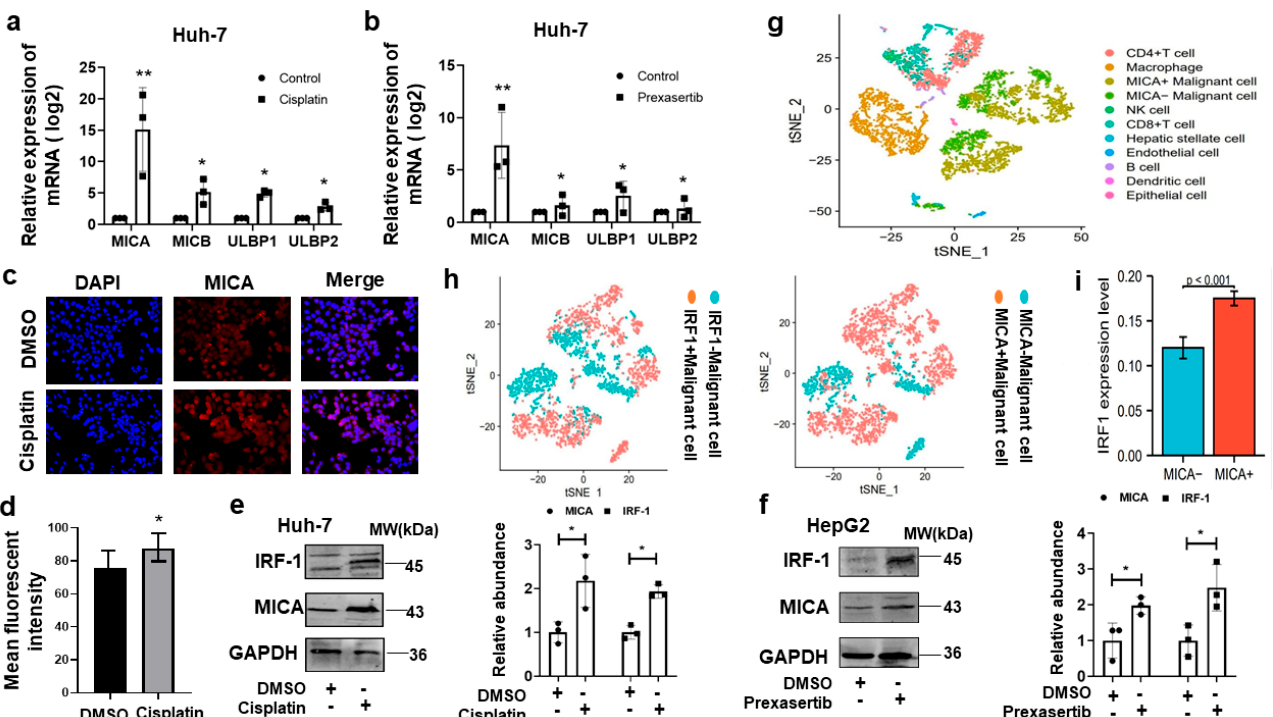
Figure 4. DNA damage induced MICA expression via IRF1 in HCC cells. The relative mRNA expression of NKG2D ligands is determined by qPCR in Huh-7 cells induced by cisplatin with a dose of 5 μ M for 24 h ( a ) and prexasertib with a dose of 5 μ M for 24 h ( b ). ( c ) The representative immunofluorescent images (×400 magnification) show MICA protein level (red staining) in Huh-7 cells induced by cisplatin with a dose of 5 μ M for 24 h. ( d ) Quantification of MICA by mean fluorescent intensity is shown. The representative western blot image detected for IRF1 and MICA expression in Huh-7 ( e ) and HepG2 cells ( f ) induced by cisplatin or prexasertib with a dose of 5 μ M for 24 h are shown, respectively. The quantitative analyses are shown on the right. ( g ) The different types of cells in the human HCC tumor are shown by their own specific marker on scRNA-seq from the GEO database. ( h ) IRF1 expression is consistent with MICA in tumor cells. ( i ) The statistical analysis of IRF1 expression level in HCC tumor cells with positive MICA expression is shown. Data represent mean ± SD, * p < 0.05, ** p < 0.01. The western blot and immunofluorescent results are representative images from three independent experiments. The uncropped blots are shown in Supplementary Figure S1.